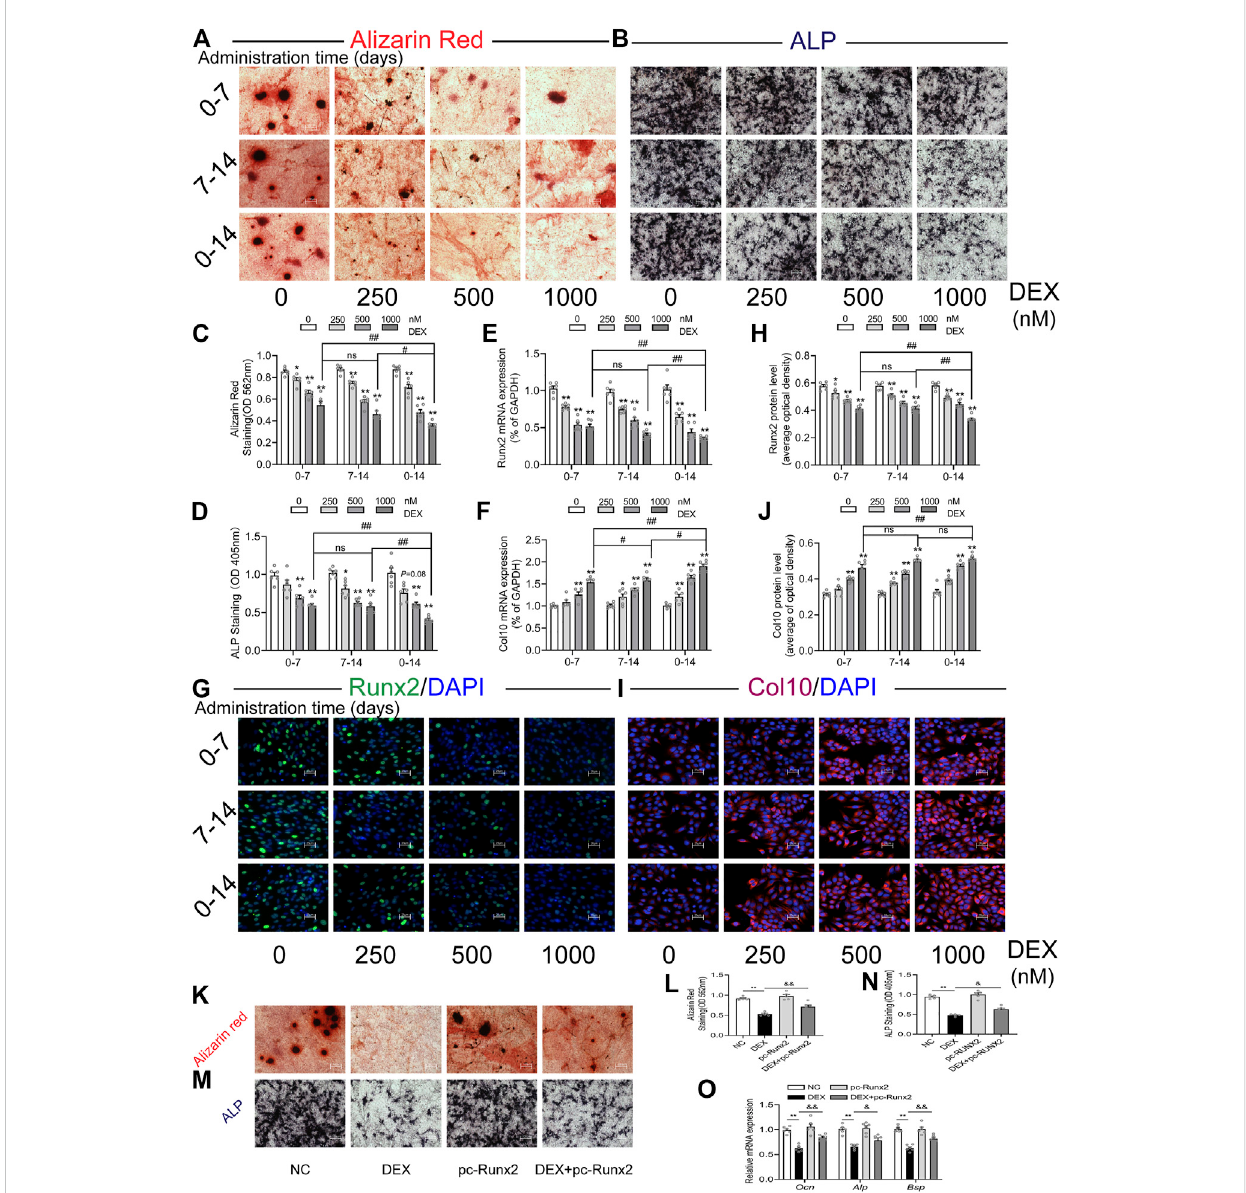
Effects of different times and concentrations of dexamethasone on trans-differentiation of primary growth plate chondrocytes into osteoblasts. (A) . Typical images of alizarin red staining; (B) . Typical images of alkaline phosphatase (ALP) staining; (C) . Quantitative analysis of alizarin red staining; (D) . Quantitative analysis of ALP staining; (E) . The mRNA expression of Runx2; (F) . The mRNA expression of Col10; (G) . Typical immuno fl uorescence images of Runx2; (H) . Typical immuno fl uorescence images of Col10; (I) . Quantitative analysis of Runx2 protein level; (J) . Quantitative analysis of Col10 protein level; (K) . Alizarin red staining after treatment with dexamethasone and Runx2 overexpression plasmid; (L) . Quantitative analysis of alizarin red staining after treatment with dexamethasone and Runx2 overexpression plasmid; (M) . ALP staining after treatment with dexamethasone andRunx2 overexpression plasmid; (N) . Quantitative analysis of ALP staining after treatment with dexamethasone and Runx2 overexpression plasmid; (O) . Expression of marker genes for osteogenic differentiation after treatment with dexamethasone and Runx2 overexpression plasmid * p < 0.05 , **p < 0.01 , Control vs. dexamethasone treatment group. # p < 0.05 , ## p < 0.01 , compared with different times of dexamethasone treatment. & p < 0.05 , && p < 0.01 , DEX treatment group v.s. DEX + pc-Runx2 treatment group. DEX, dexamethasone; GAPDH, glyceraldehyde 3-phosphate dehydrogenase; Runx2, Runt-related transcription factor 2; Col10, collagen type